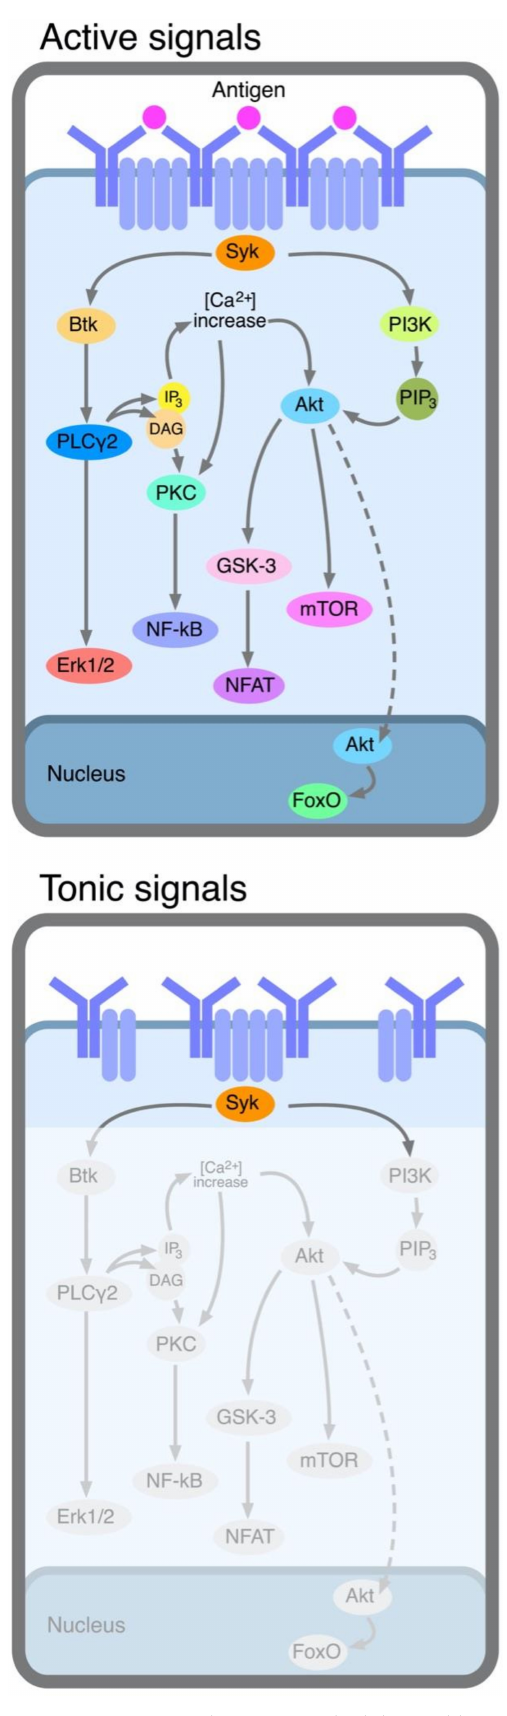
Figure 1. Active and tonic signals delivered by BcRs to CLL cells. Active signals (top). The BcR